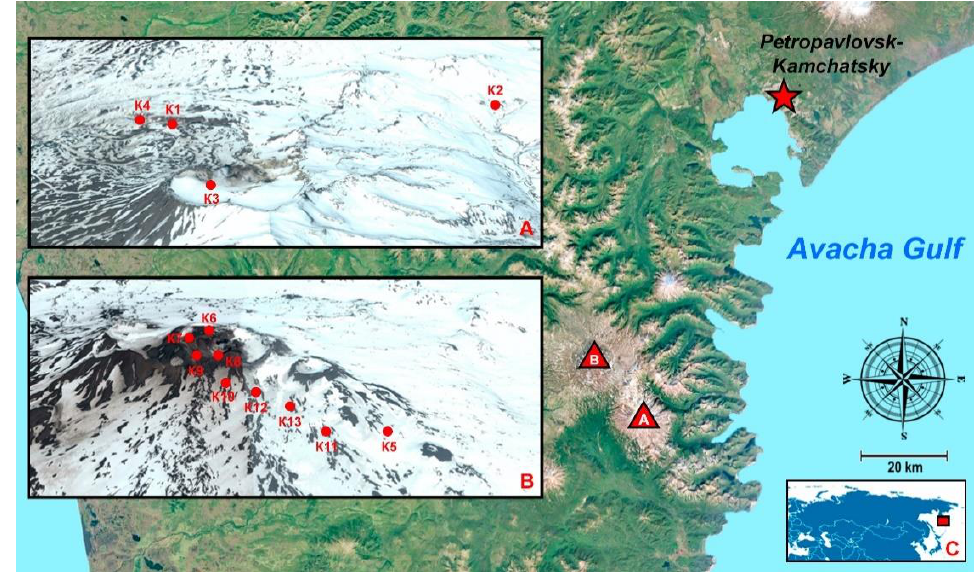
Figure 1. Study area. The red star indicates Petropavlovsk-Kamchatsky city; red triangle with letter ( A )—Gorely volcano, red triangle with letter ( B )—Mutnovsky volcano; ( A )—Mutnovsky volcano, red dots indicate sites K1–K4; ( B )—Gorely volcano, red dots indicate sites K5–K13; ( C )—red rectangle indicates the Kamchatka peninsula .